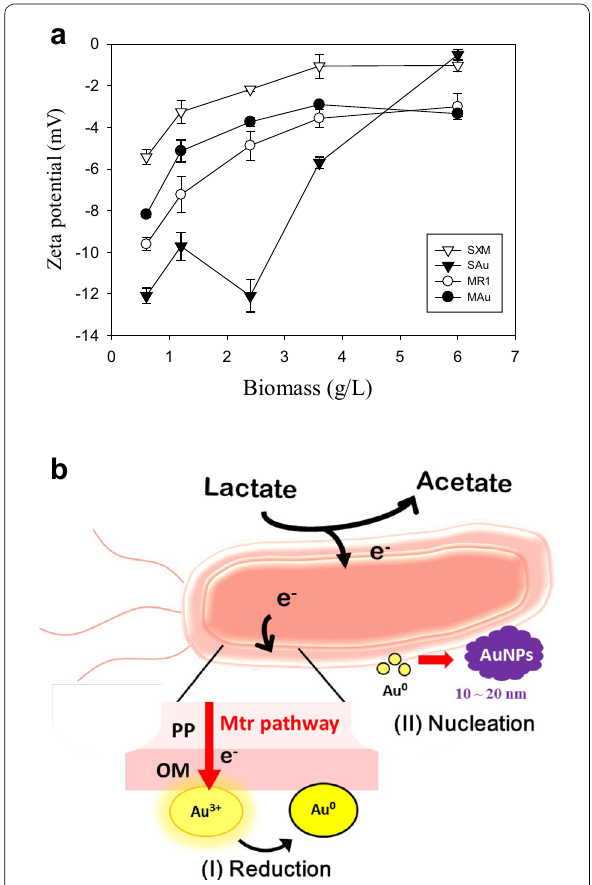
Fig. 4 a Zeta potential analysis of S. oneidensis MR‑1 and S. xiame- nensis BC01 before and after the formation of Au@NPs. b Proposed mechanism of Au@NP production using Shewanella